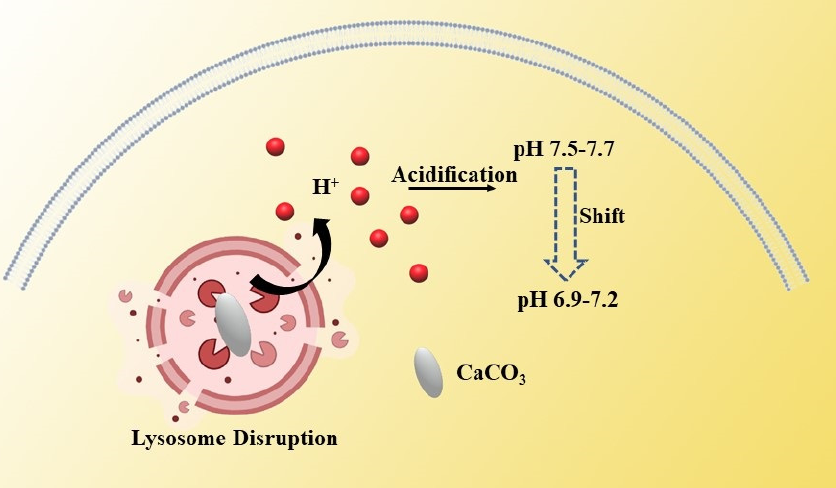
Figure 2. Schematic illustration of H + —induced antitumor therapy. The expansion of CaCO 3 nanoparticles will lead to lysosome expansion and the extrusion of a large amount of H + , resulting in intracellular acidification.